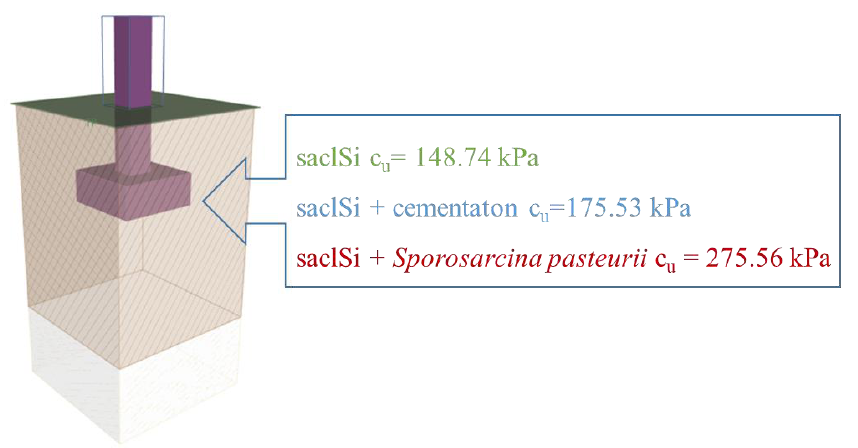
Figure 11. The analysed direct foundation together with the shear strength values of the analysed soils.